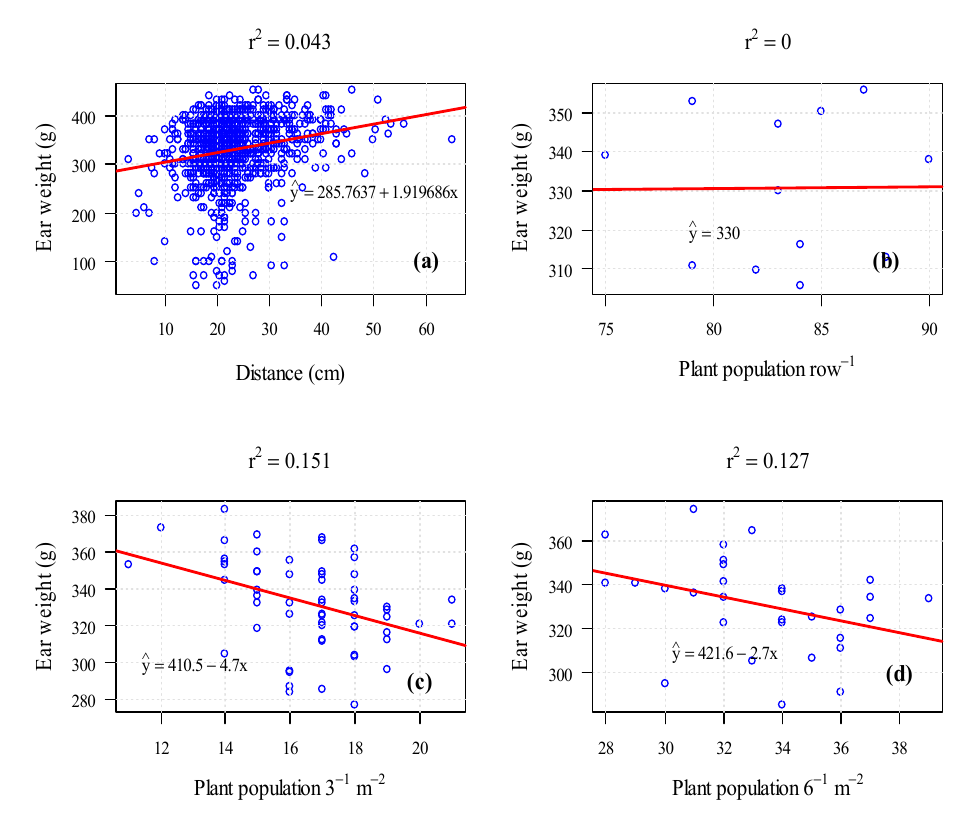
Figure 2. Relationship between the ear weight and ( a ) the plant distance, ( b ) the plant population per row, and ( c , d ) the plant population in 3 and 6 m 2 , 2017. r 2 is the determination coefficient. The statistical data for the different mosaic sizes are different (Table 3). The sizes are equivalent, there is no preferred one for the description of the relationship between the population and the individual performance. Table 3. Results of the regression analysis for different mosaic sizes, 2017. The independent and the dependent variables were plant population (plant m − 2 ) and ear weight, respectively.